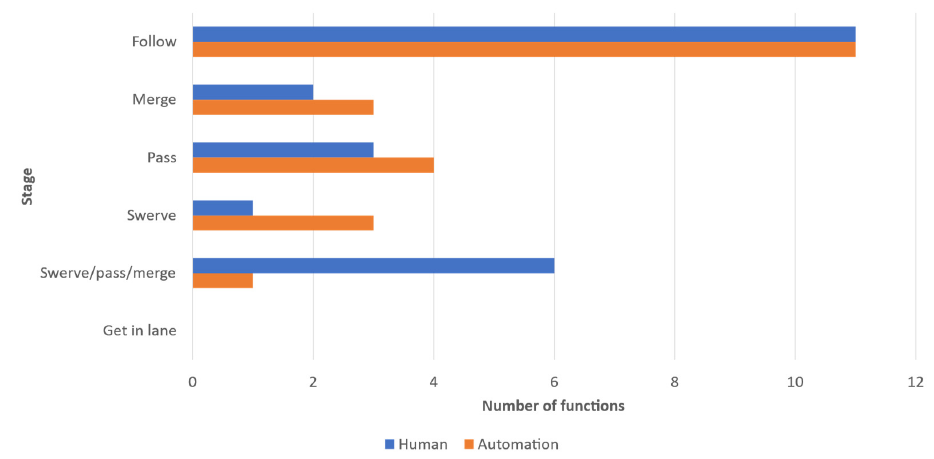
Figure 7. Comparison of the risk distribution over the stages between human and automation.